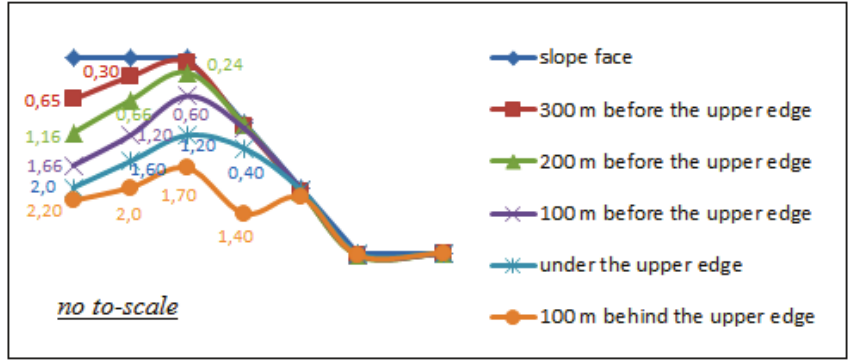
Fig. 14. Vertical displacement of slope face when the longwall operation proceeds from the left side towards the upper edge of slope (measured point is the face of the longwall panel)